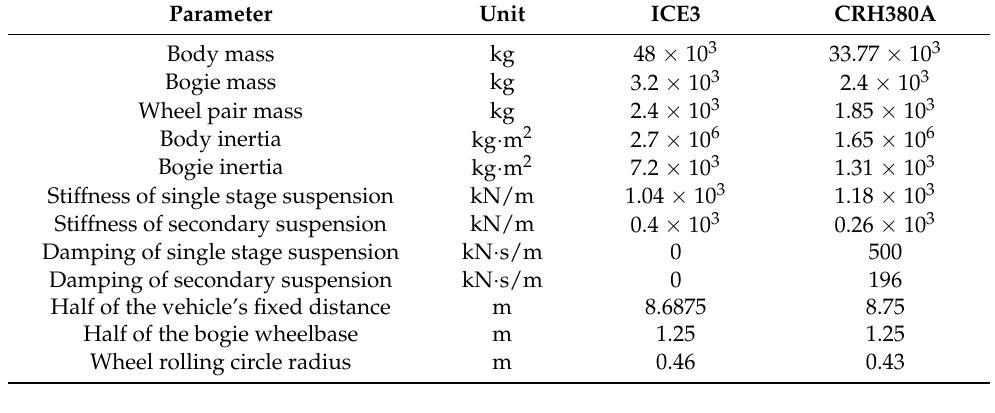
Table 1. Vehicle parameters.